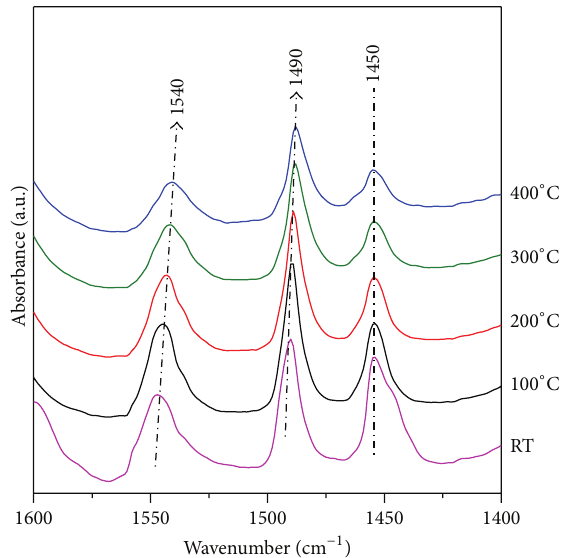
Figure 3: IR spectra of pyridine adsorption on 0.5 Zn/ZSM-5 at different desorption